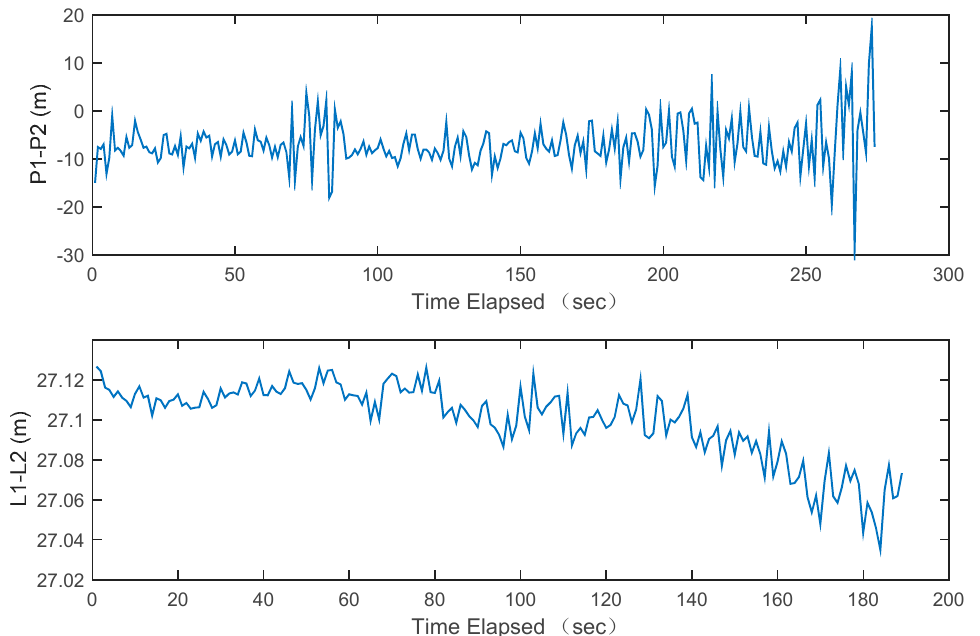
Figure 11. The observation noise structure of Luojia-1A pseudorange and carrier phase measurement evaluated via the geometry-free combination.